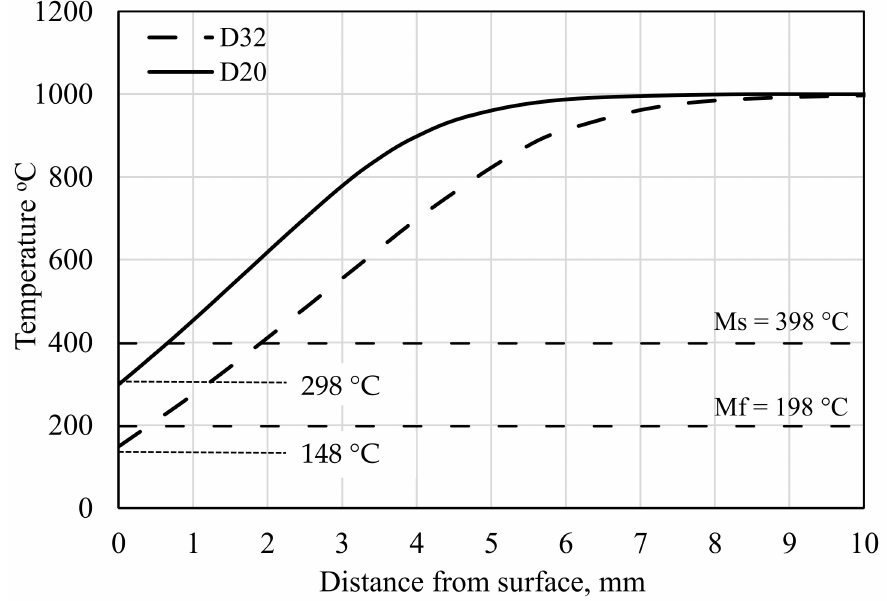
Figure 10. Temperature distribution after quenching for the studied rebars